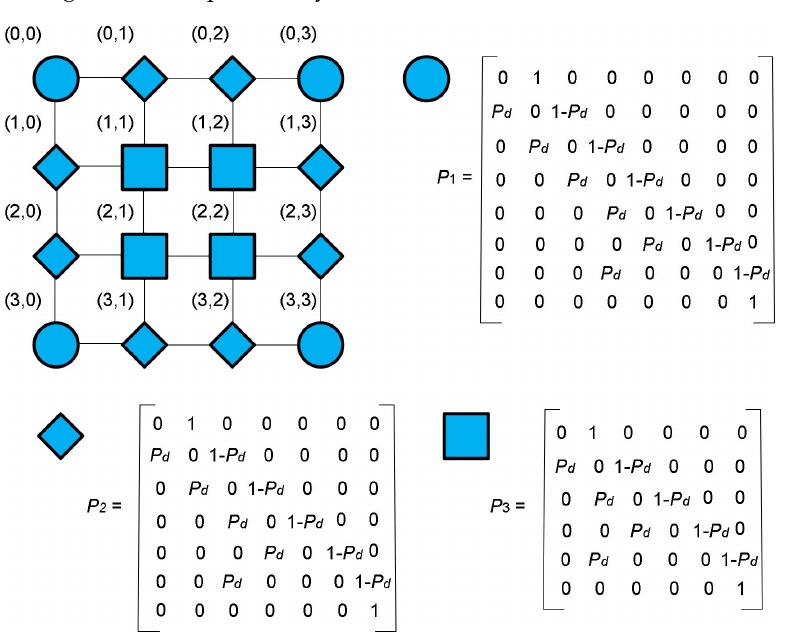
Figure 2. Markov chain transition matrices for a 4 × 4 2D NoC topology. The source − destination pair of Figure 1 corresponds to the third row of the second transition matrix. The three distance classes of nodes are indicated using different node